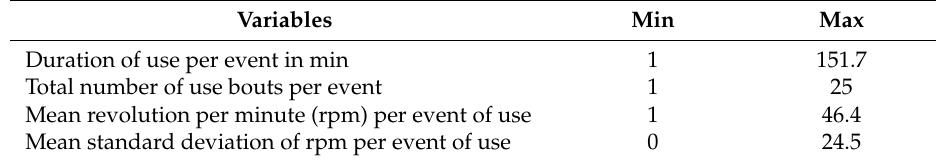
Table 3. Minimum and maximum values of characteristics of use per event (817) for 36 participants.